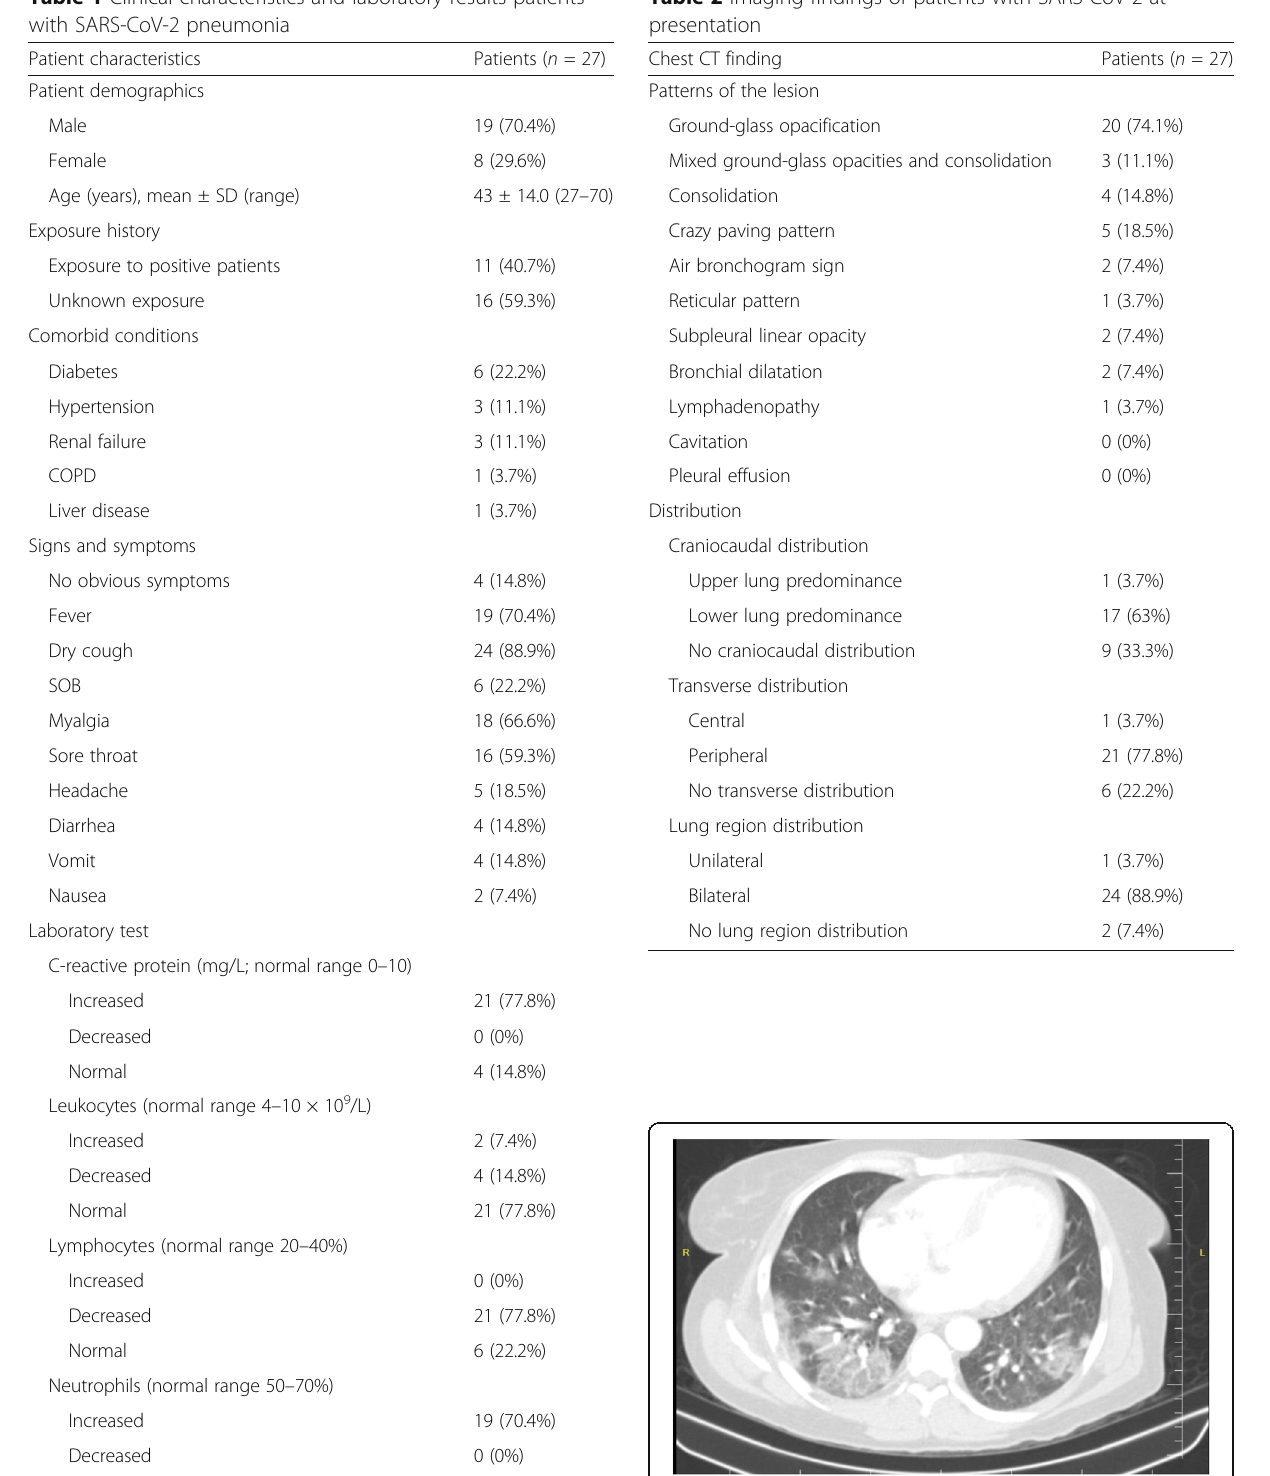
Table 2 Imaging findings of patients with SARS-CoV-2 at